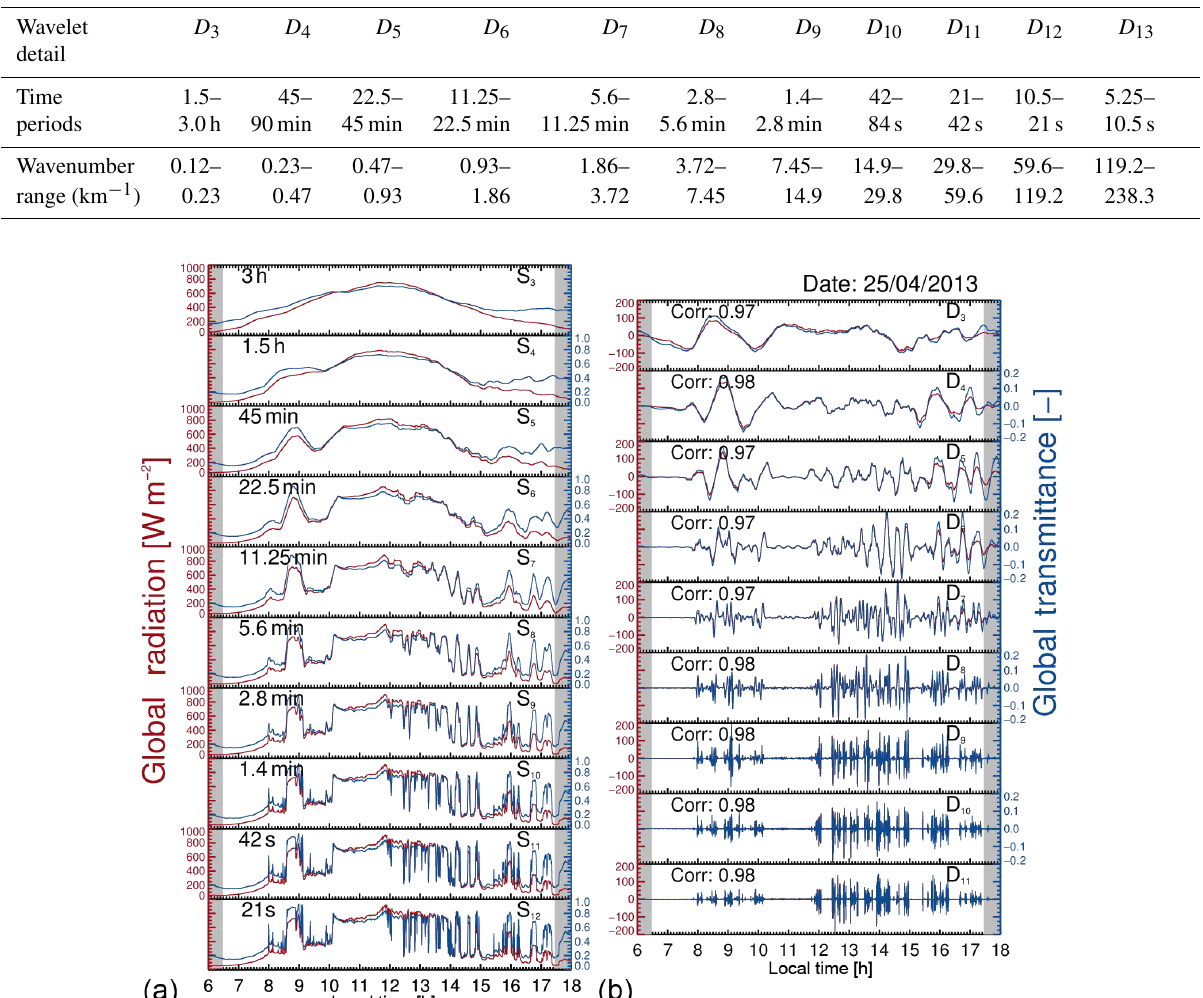
Figure 2. Multiresolution analysis of global radiation (red) and corresponding transmittance (blue) showing smooths (left panel) and details (right panel) as a function of local time (in hours, h) for a pyranometer station at FZJ on 25 April 2013. Shaded gray region on both panels correspond to the region with solar zenith angle > 75 ◦ . The smoothing time is given in the left panels, while the correlation of the details in global radiation and transmittance is listed in the right